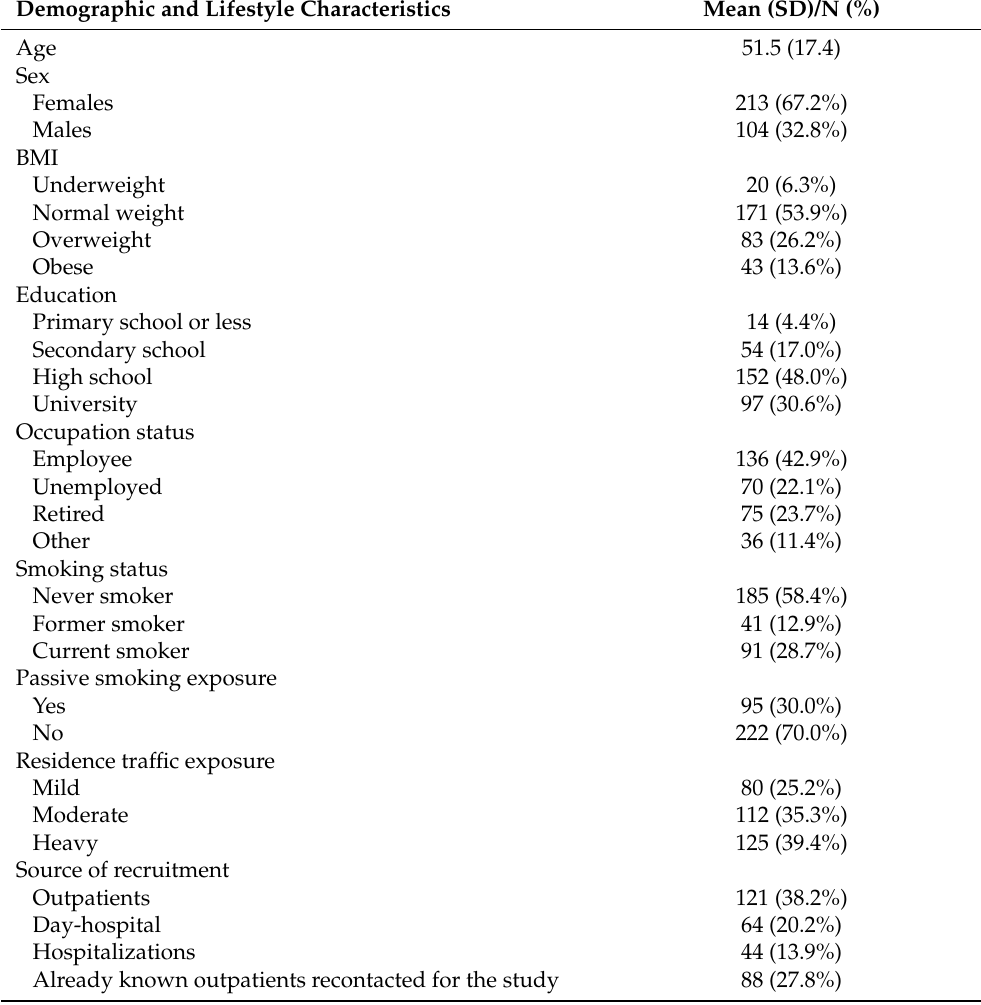
Table 1. Demographic and lifestyle characteristics of 317 study subjects recruited until 1 July